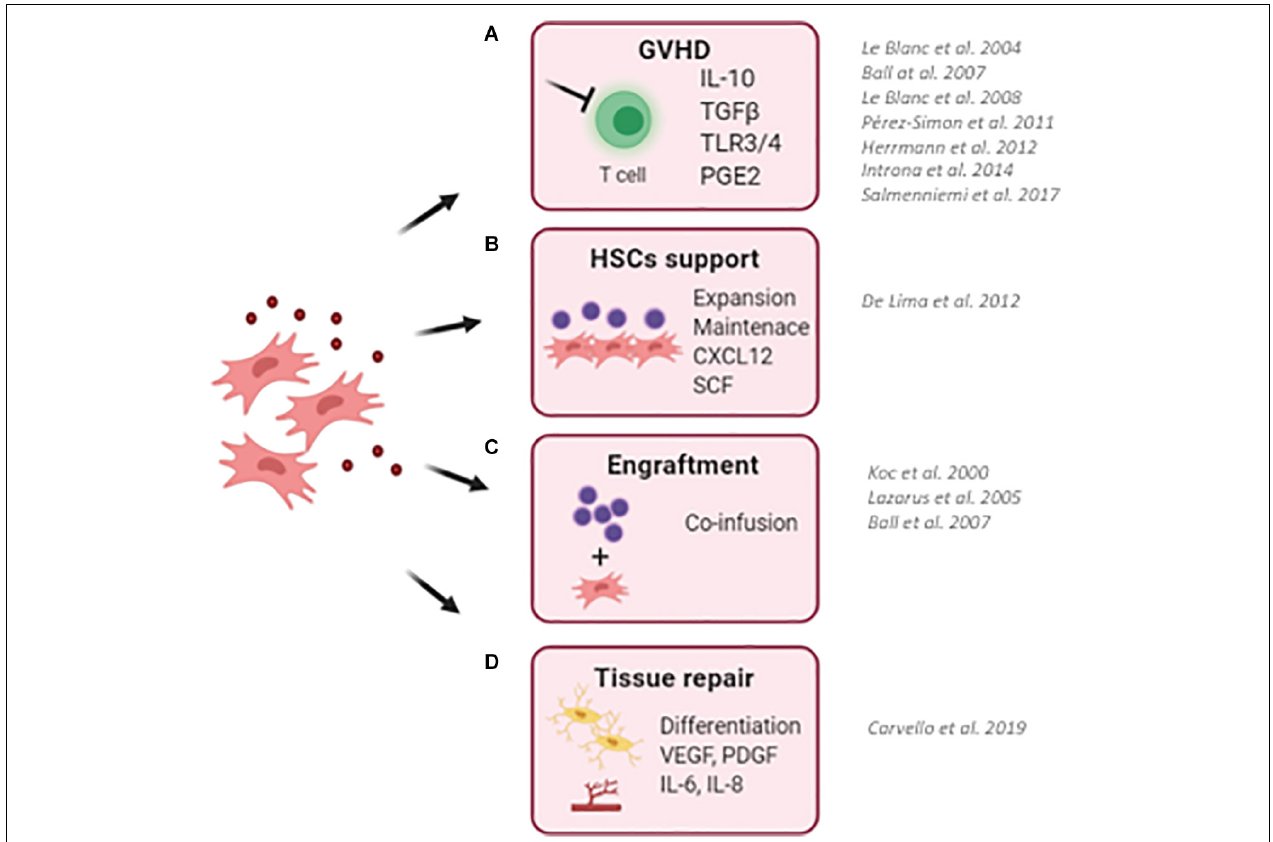
FIGURE 1 | Schematic representation describing the clinical use of MSCs in the context of hematopoietic stem cell transplantation (HSCT). (A) MSCs has been successfully employed to reduce the risk and to treat graft-versus-host disease (GvHD) in transplanted pediatric and adult patients. Thanks to their ability to sense inflammatory stimuli, MSCs are capable to modulate T-cell proliferation and activation through the release of specific immunomodulatory cytokines (IL10, TGFb, and PGE2). (B) MSCs have been used as a feeder to expand and maintain UCB-CD34 + HSCs before transplantation due to their ability to secrete HSC supportive factors. (C) The co-infusion of MSCs has been demonstrated to promote HSC engraftment and accelerate hematological reconstitution in transplanted patients. Despite only a small percentage of infused MSCs reaches the BM niche, the production and release of supportive factors by co-infused MSCs ameliorates the outcome of HSCT. (D) The ability of MSC to repair and differentiate in bone cells makes them an attractive cell candidate to restore a proper BM niche, with MSCs and MSC-derived osteoblasts capable of supporting HSCs. (BM, bone marrow; UCB, umbilical cord blood). For each clinical application, works describing clinical trials for the use of MSCs are